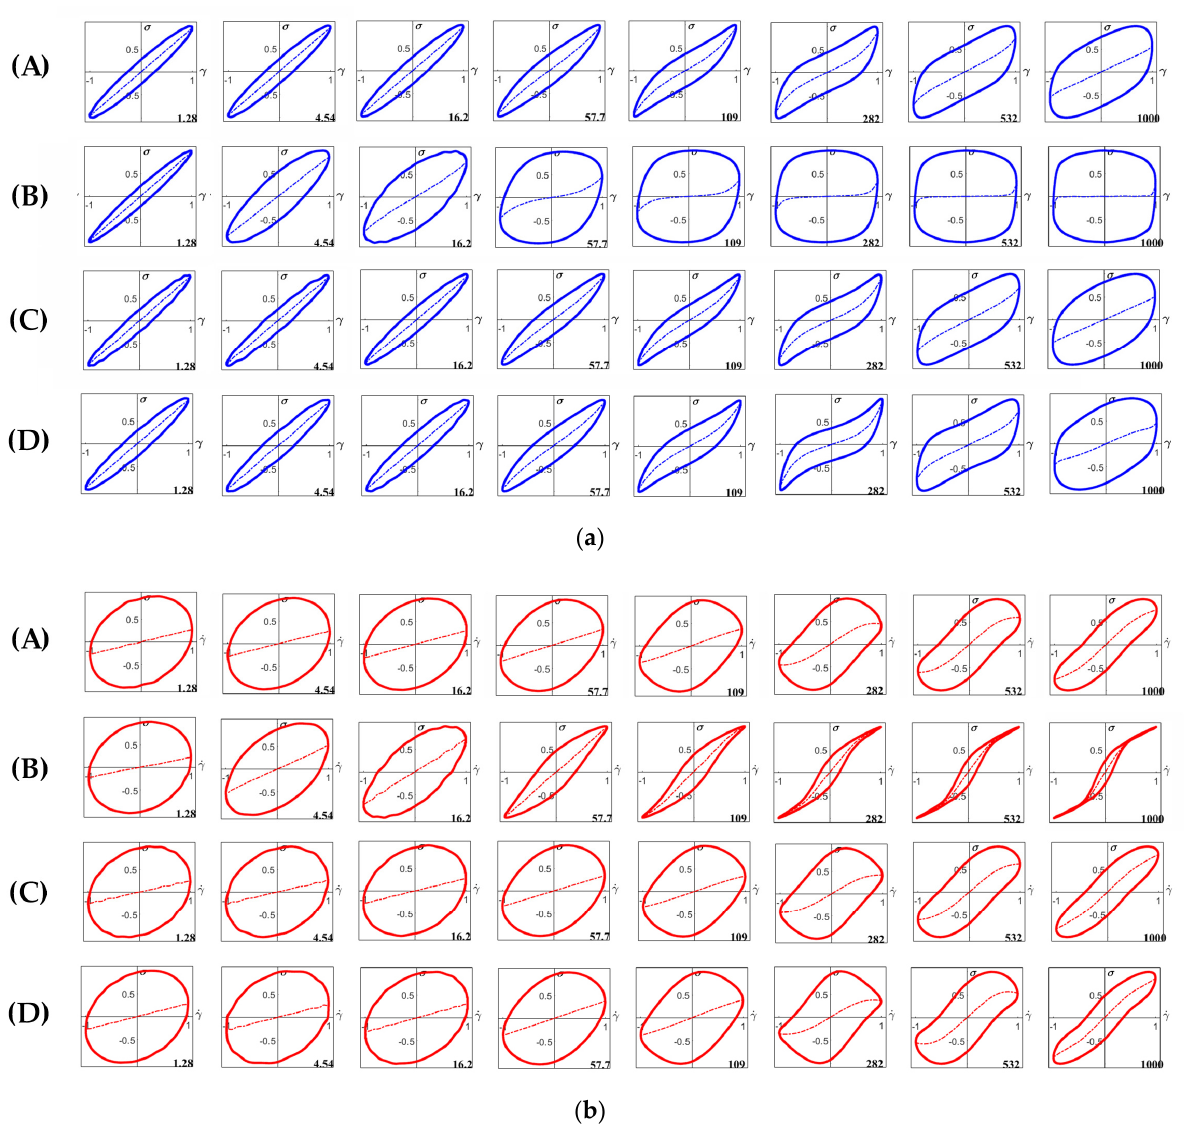
Figure 9. ( a ) Lissajous plots of stress versus strain ( τ ( γ )) for starch gels in the neutral system with shear strains ( γ ) of (from left to right) 1.28%, 4.54%, 16.2%, 57.7%, 109%, 282%, 532% and 1000% at 25 ◦ C: ( A ) TS, ( B ) RS, ( C ) WTS, and ( D ) WRS. Dashed curves inside the loops indicate the contribution of the elastic stress to the total stress [34]. ( b ) Lissajous plots of stress versus strain rate ( τ ( starch gels in the neutral system with shear strains ( γ ) of (from left to right) 1.28%, 4.54%, 16.2%, 57.7%, 109%, 282%, 532% and 1000% at 25 ◦ C: ( A ) TS, ( B ) RS, ( C ) WTS, and ( D ) WRS. Dashed curves inside the loops indicate the contribution of the viscous stress to the total stress